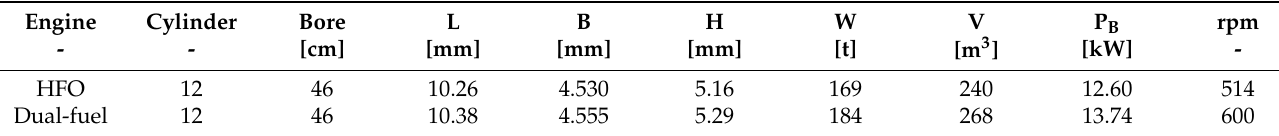
Table 6. Properties of both the HFO and the dual-fuel